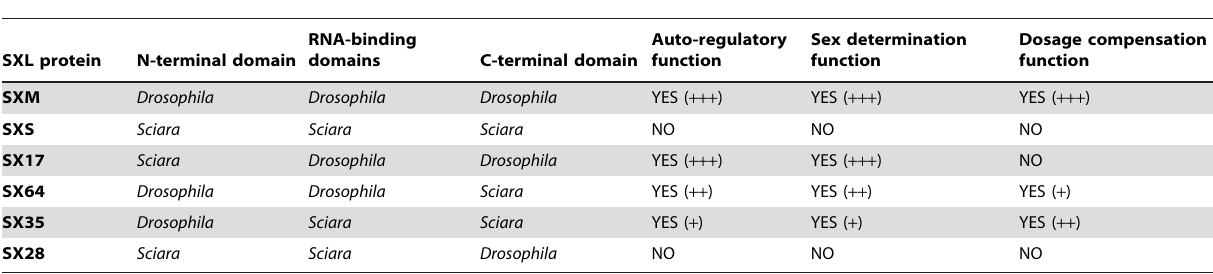
Table 3. Function of the transgenic Drosophila-Sciara chimeric SXL